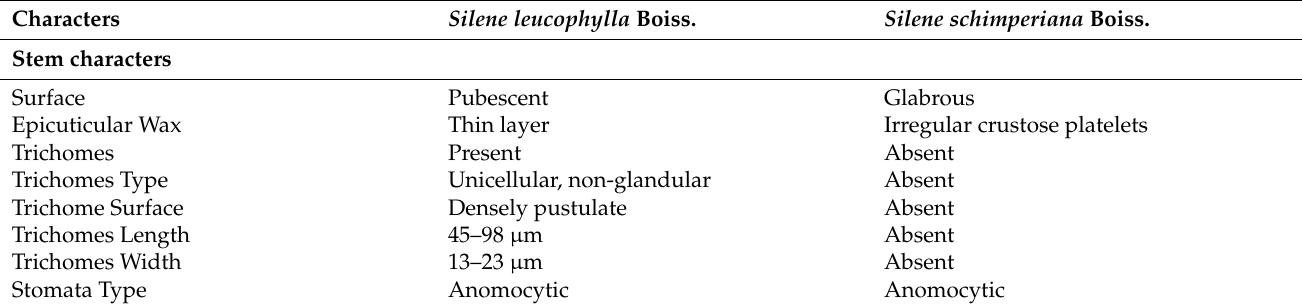
Table 1. Qualitative characteristics of stem and leaf Abaxial leaf (AB) and Adaxial leaf (AD) characters of Silene leucophylla and Silene schimperiana